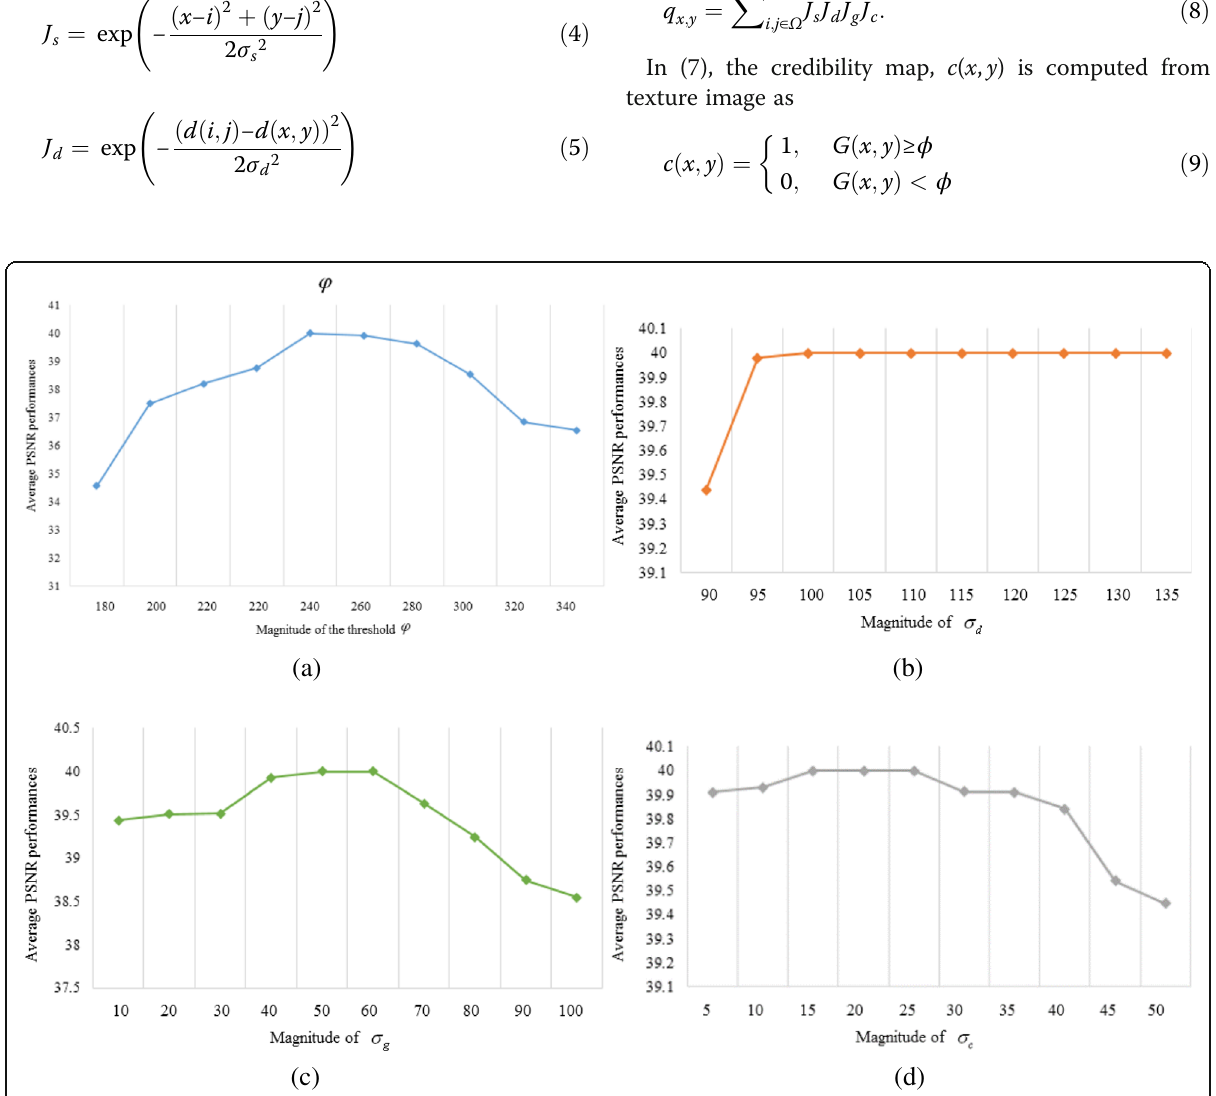
Fig. 5 Average PSNR performances for a the threshold φ , b the standard deviation σ d , c the standard deviation σ g , d the standard deviation σ